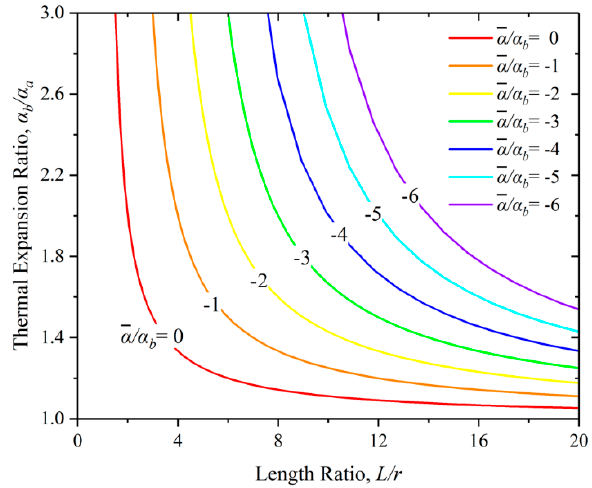
Figure 2. Contours of normalized net thermal expansion ratio ⎯ α / α b for a range of length ratio of the long rod and the virtual rod, L/r.